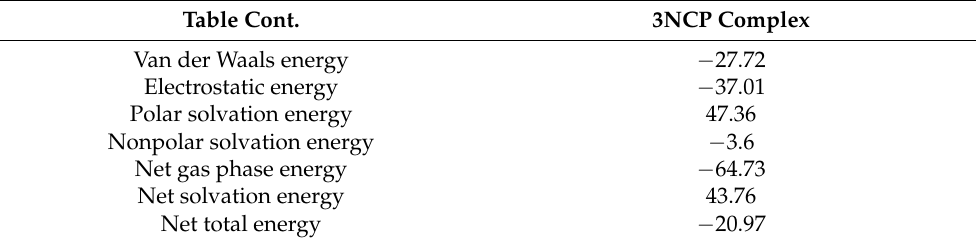
Table 1. MM/GBSA Derived Binding Free Energies of 3NCP-BACE1 Complex Estimated Using Different GB Models.